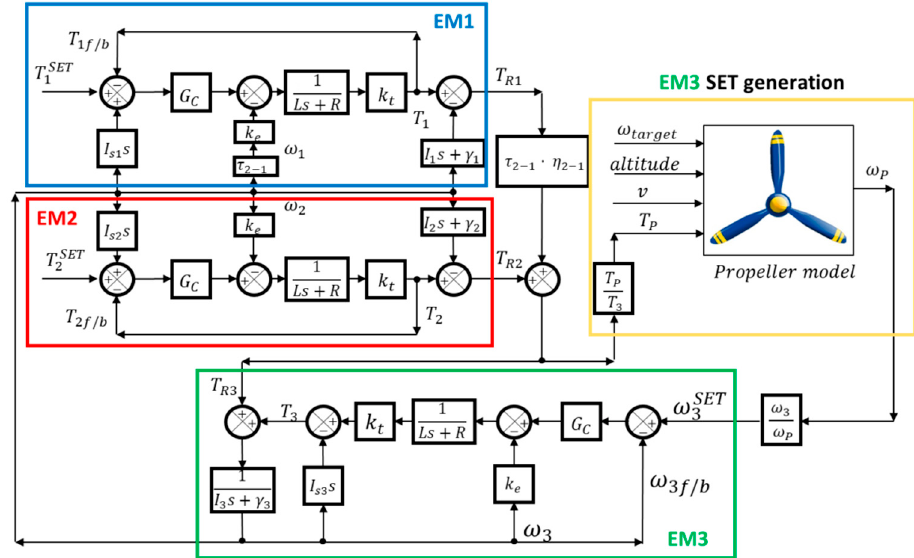
Figure 6. Block diagram of the virtual test bench during the take-off phase.